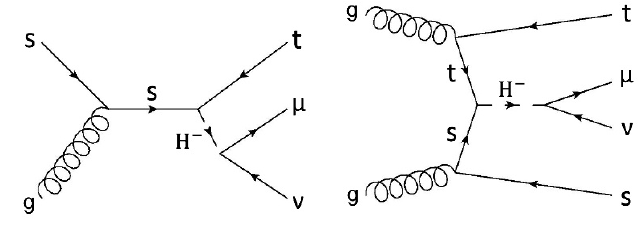
Figure 9 . Diagrams that contributes to the (cid:22)(cid:23)